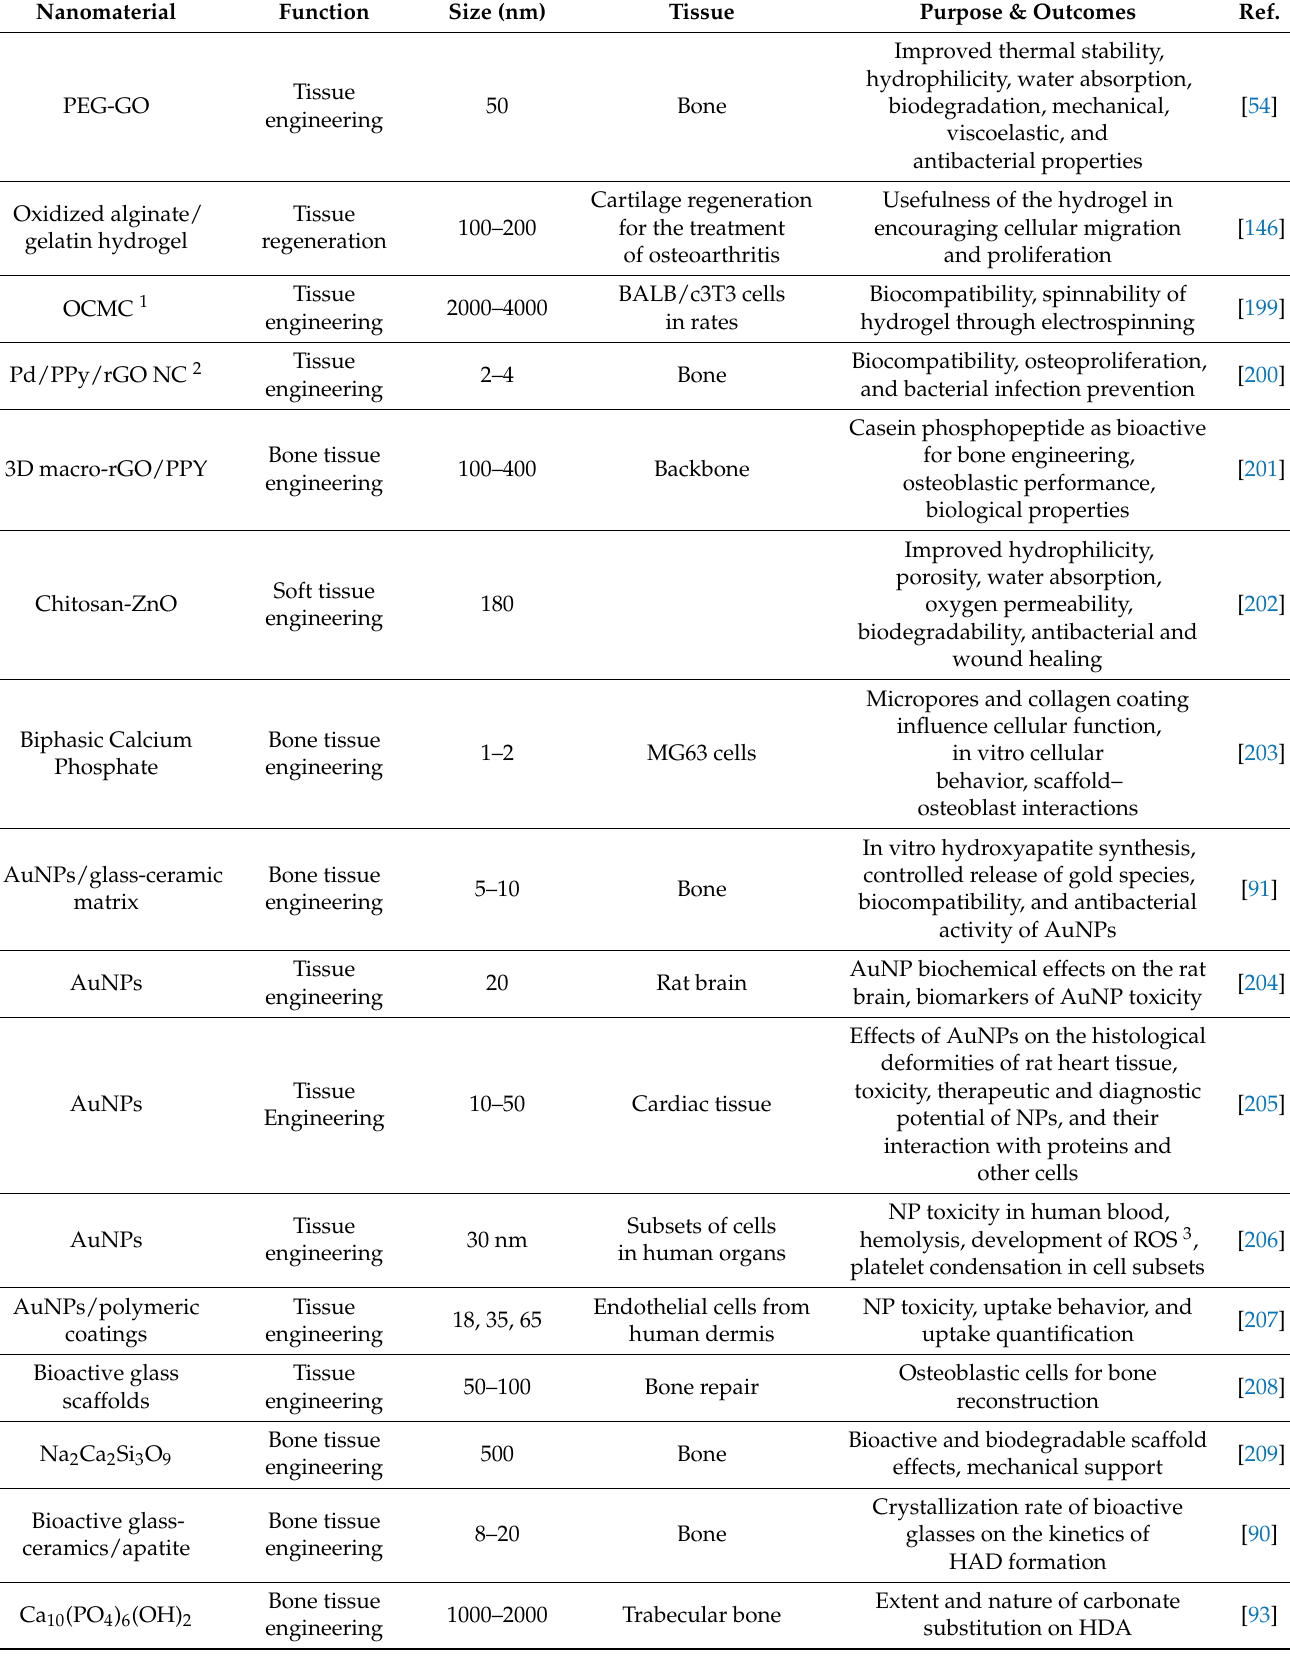
Table 3. Functionalized nanomaterials utilized in tissue